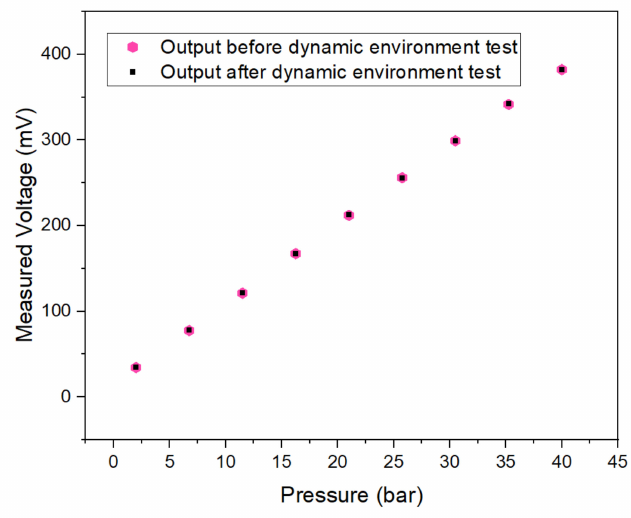
Figure 13. Sensor output before and after dynamic